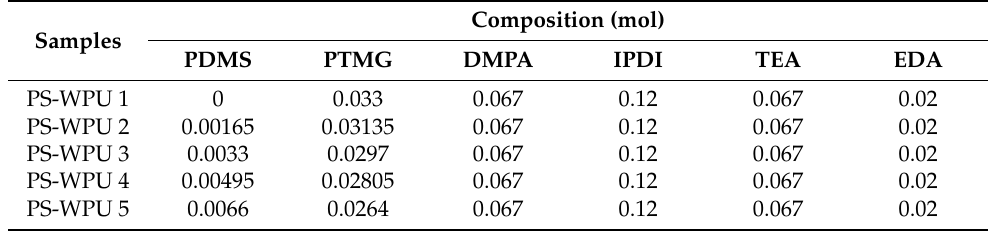
Table 1. Composition of PS-WPU